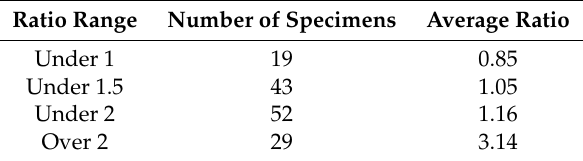
Table 1. Number of specimens with scabbing failure.